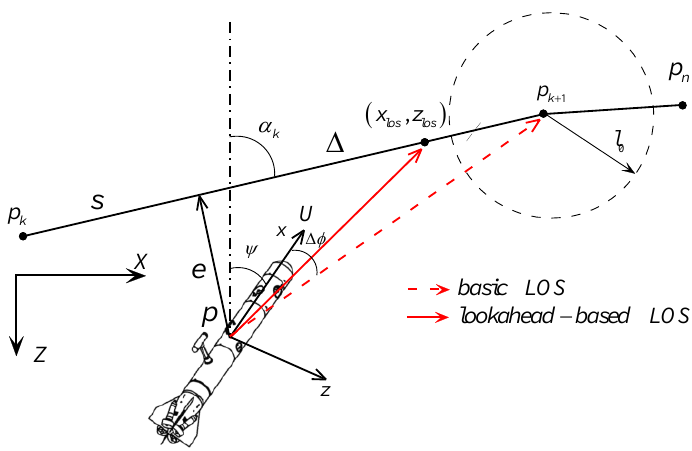
Figure 11. Depiction of LOS-based guidance. ( s , along-track distance; e , cross-track error; △, lookahead distance; n p , waypoint).